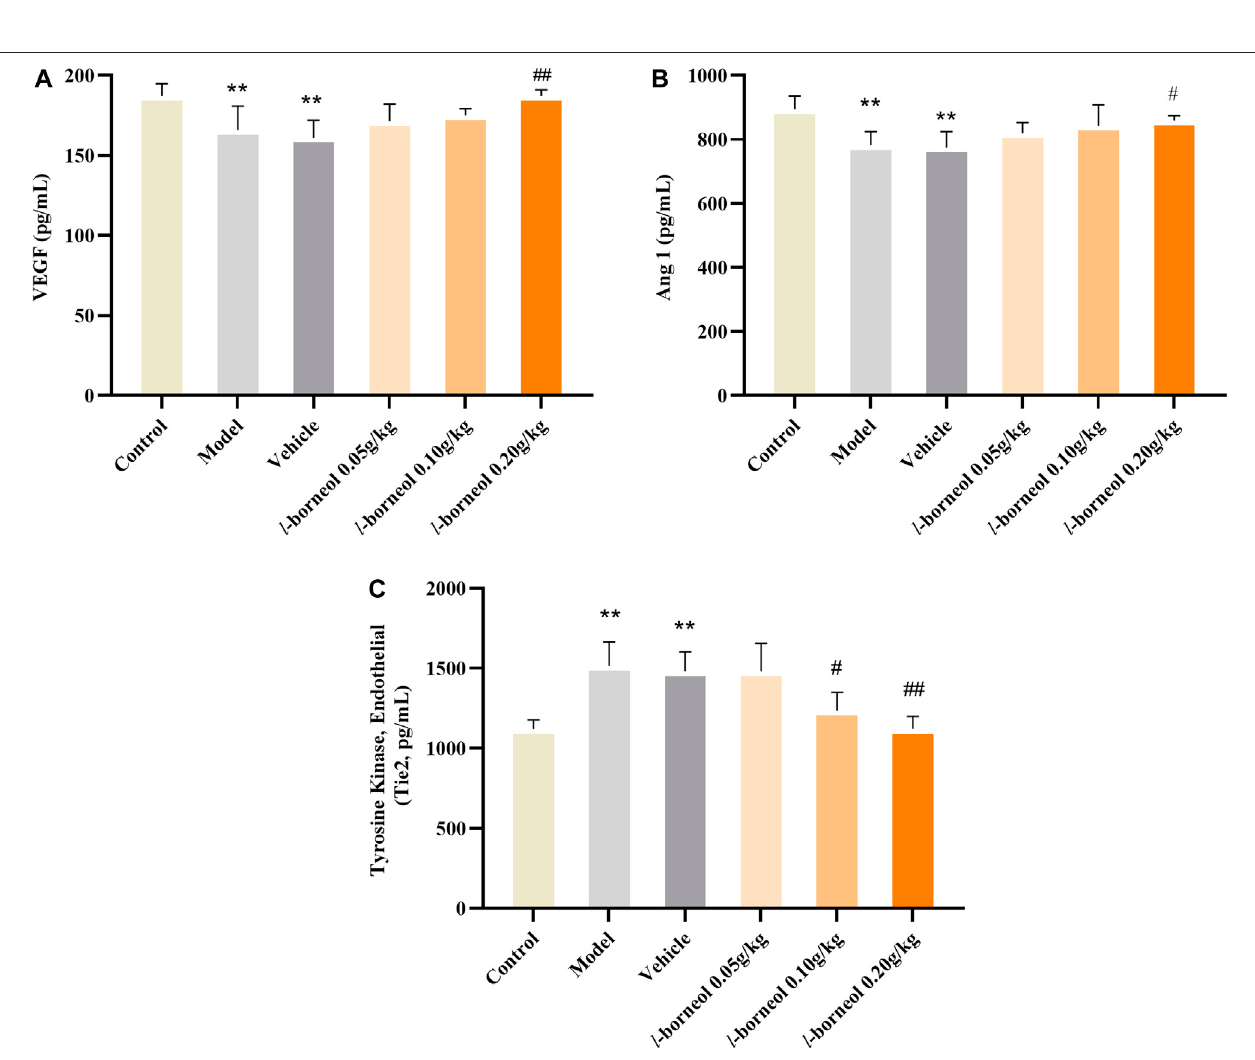
FIGURE 4 | Illustration of VEGF, Ang1 and Tie two in the serum using ELISA ( n (cid:2) 6). ** p < 0.01, compared with the control group; # p < 0.05, ## p < 0.01, compared with the vehicle group.